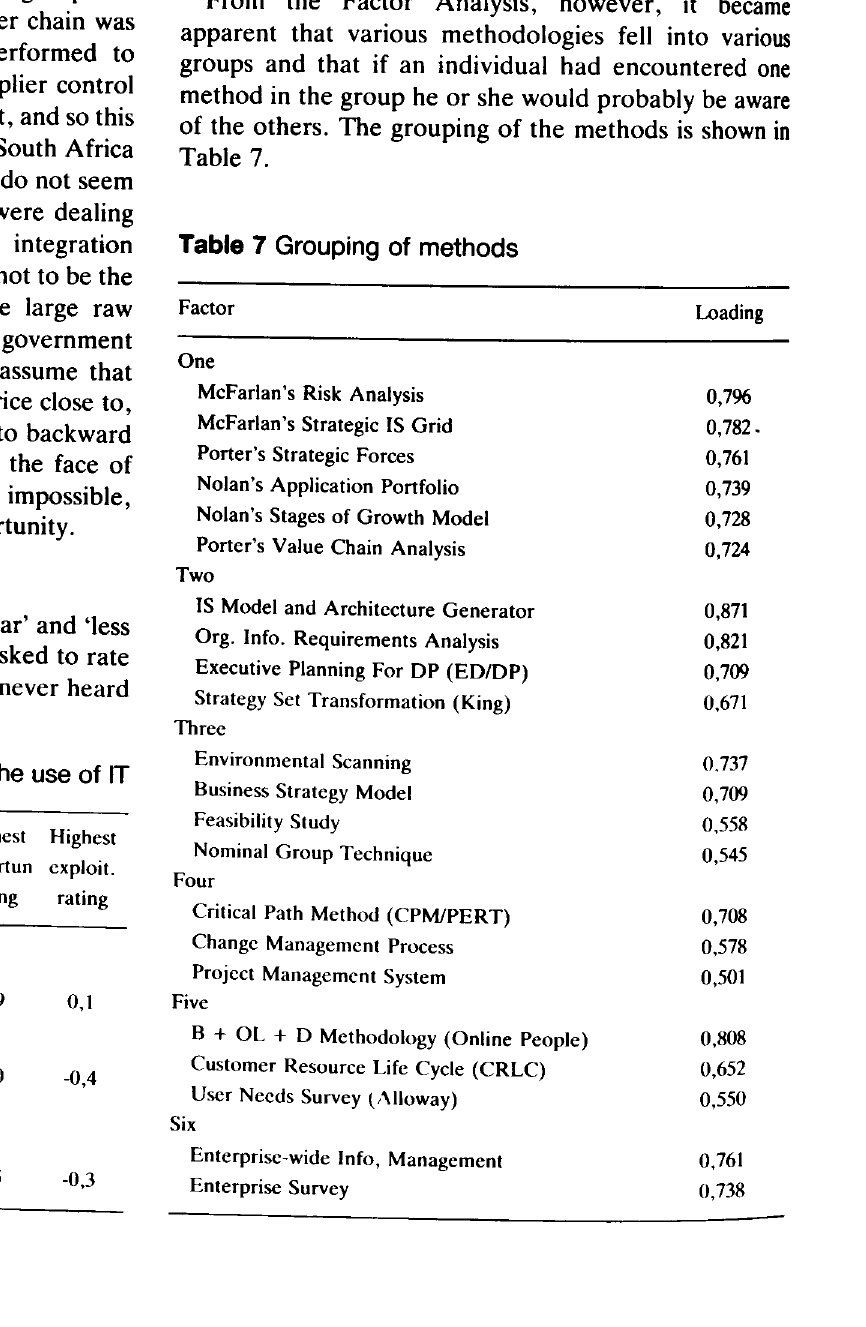
Opportunity for